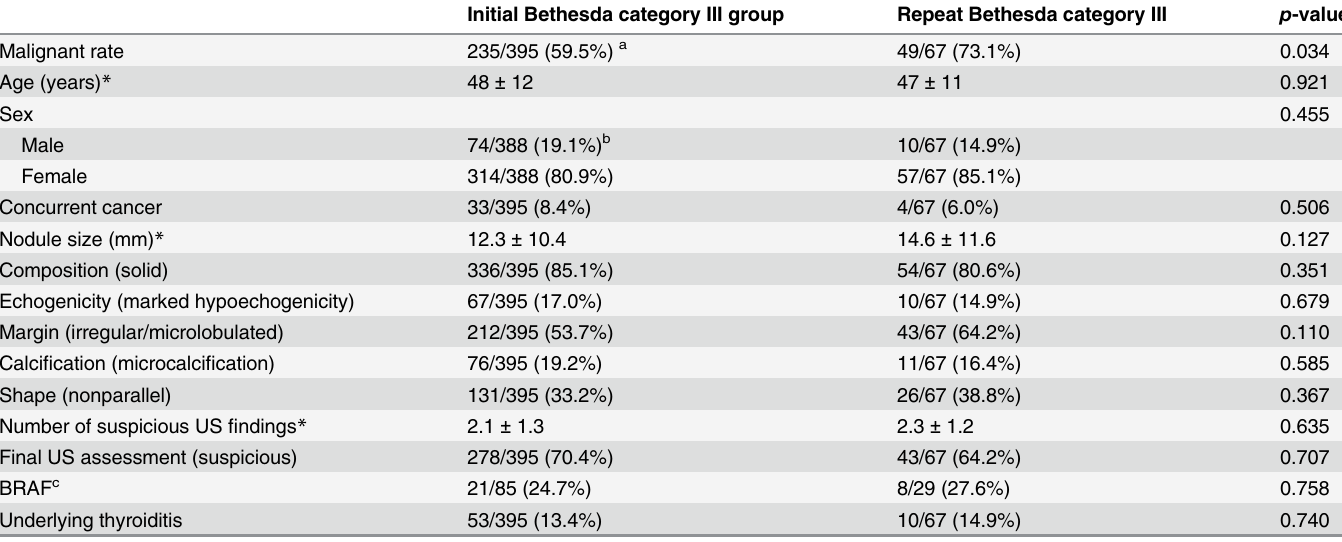
Table 2. Comparison of Malignancy Rates, Clinical and Ultrasonographic Features between Initial and Repeat Bethesda Category III